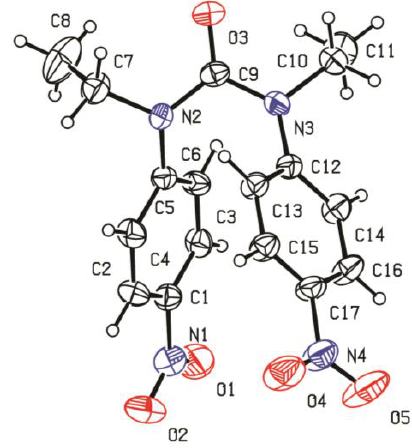
Figure 2. Crystal structure of ligand.